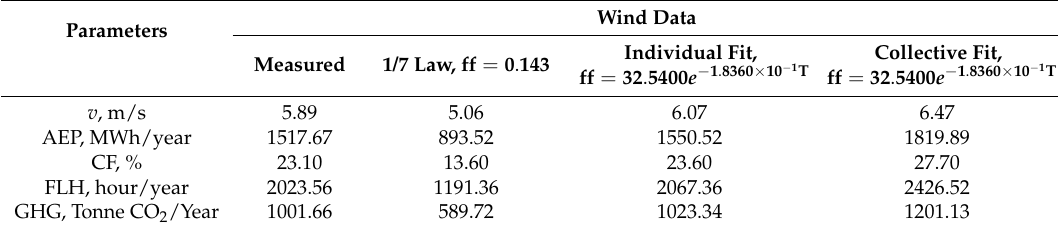
Table 9. Wind resource and energy yield parameters calculated at 60 m by the Mersing site using a single 750-kW rated power Unison U54-750 wind turbine.